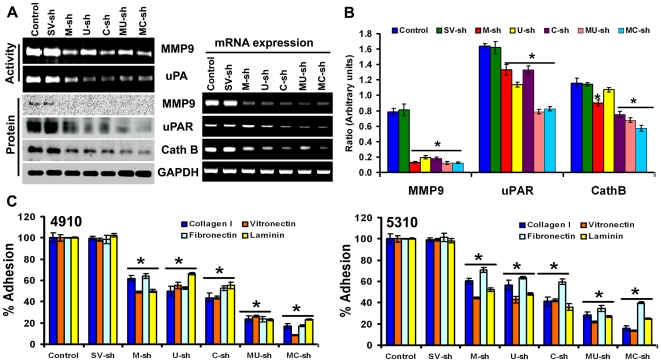
Efficiency of shRNA plasmid constructs and their effect on adhesion of xenografts to various ECM proteins.(A) Activity, protein and mRNA expressions of MMP-9, uPAR and cathepsin B in 4910 xenograft cells. MMP-9 and uPA activity was determined by gelatin and fibrin zymography after treatments with scrambled vector (SV-sh), MMP-9 (M-sh), uPAR (U-sh), cathepsin B (C-sh), MMP-9/uPAR (MU-sh) and MMP-9/cathepsin B (MC-sh) plasmid shRNAs. Western blot analysis showing MMP-9, uPAR and cathepsin B protein expression levels were reduced after M-sh, U-sh, C-sh, MU-sh and MC-sh treatments. n = 3. RT-PCR of 4910 cells transfected with SV-sh, M-sh, U-sh, C-sh, MU-sh and MC-sh was performed as per standard protocols. Further, quantification of the Western blots (B) revealed significant reductions in protein expressions after M-sh, U-sh, C-sh, MU-sh and MC-sh treatments. n = 3. Values shown are the mean (±SEM). *p<0.05 vs. control (C) Adhesion assay was performed to evaluate the effect of SV-sh, M-sh, U-sh, C-sh, MU-sh and MC-sh treatments in 4910 and 5310 glioma xenograft cells on their adhesive potential to collagen (type I), vitronectin, fibronectin and laminin coated plates. Percent adhesion was calculated from the mean obtained from 3 independent experiments and values shown are the mean (±SEM). *p<0.05 vs. control.